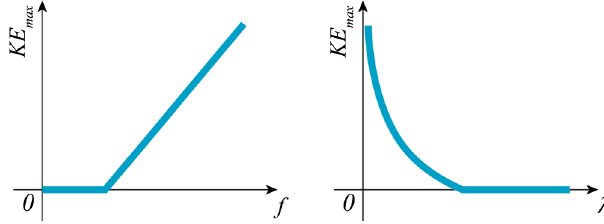
FIG. 7. Qualitatively accurate plots of KE vs f (left) and KE vs λ